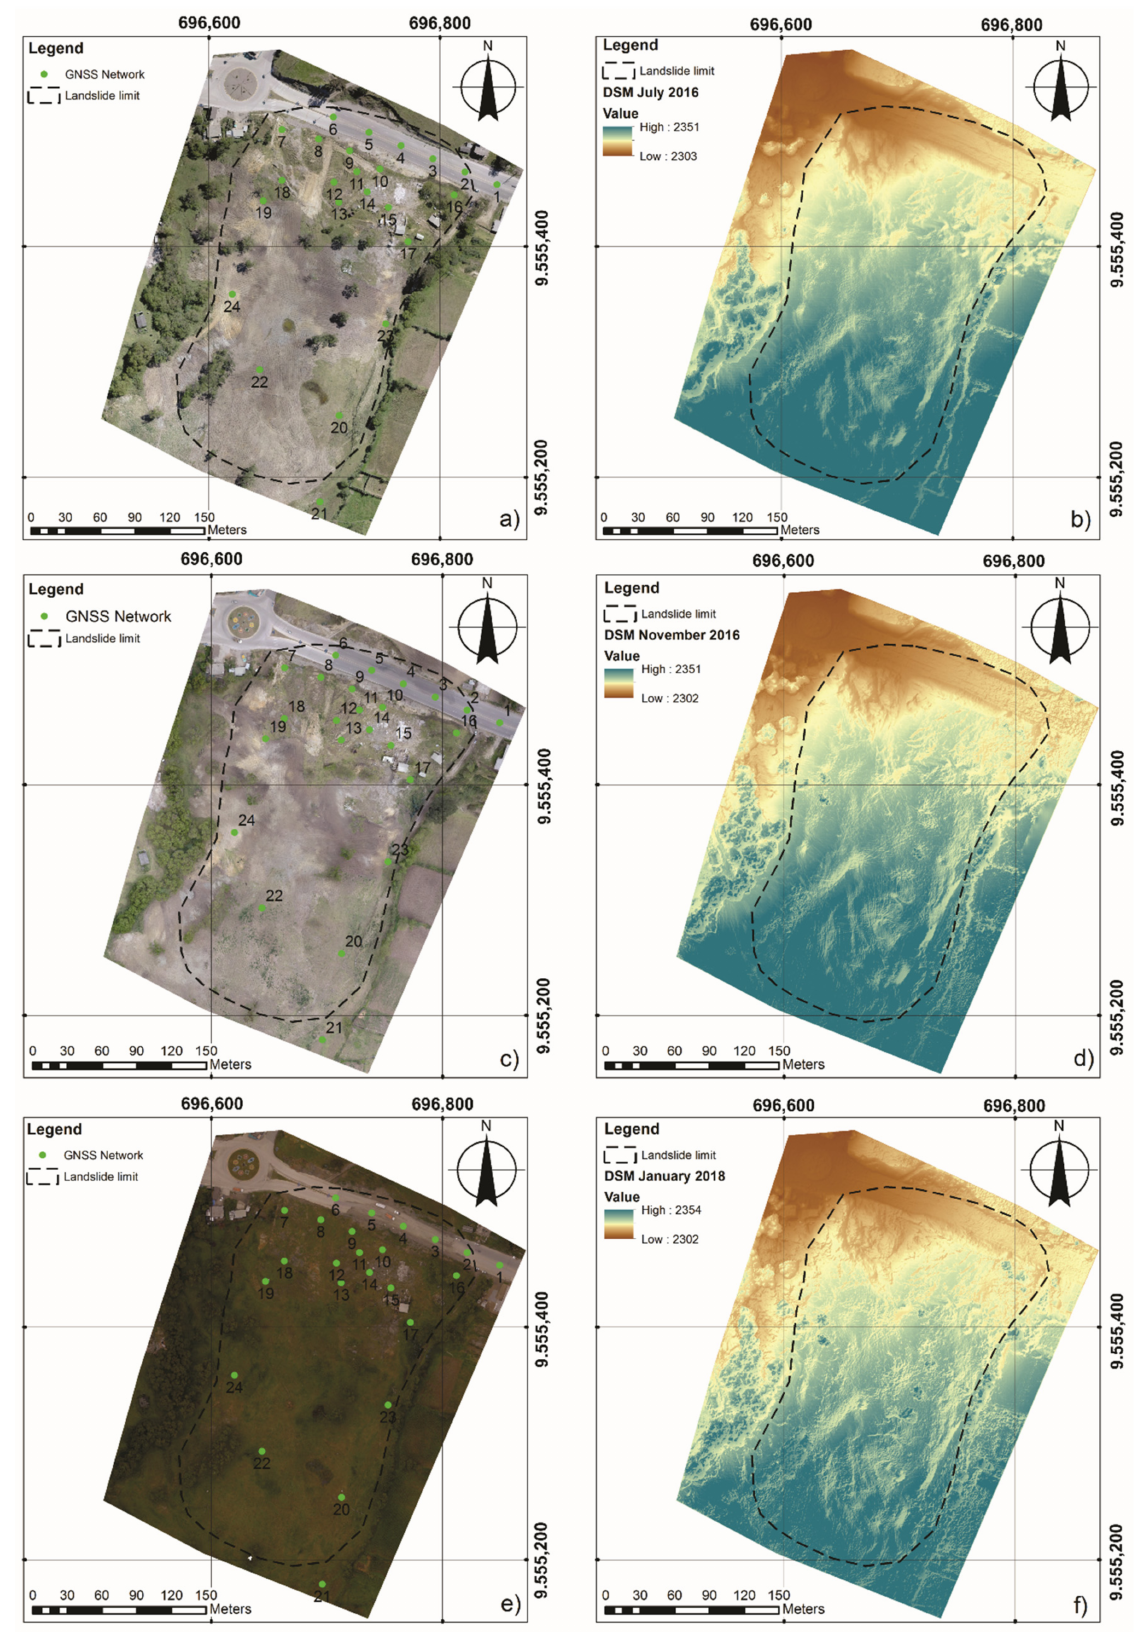
Figure 6. Orthophotos and DSMs of the Colinas Lojanas study area generated by RPAS flights: ( a , b ) 4 July 2016; ( c , d ) 29 November 2016; and ( e , f ) 12 January